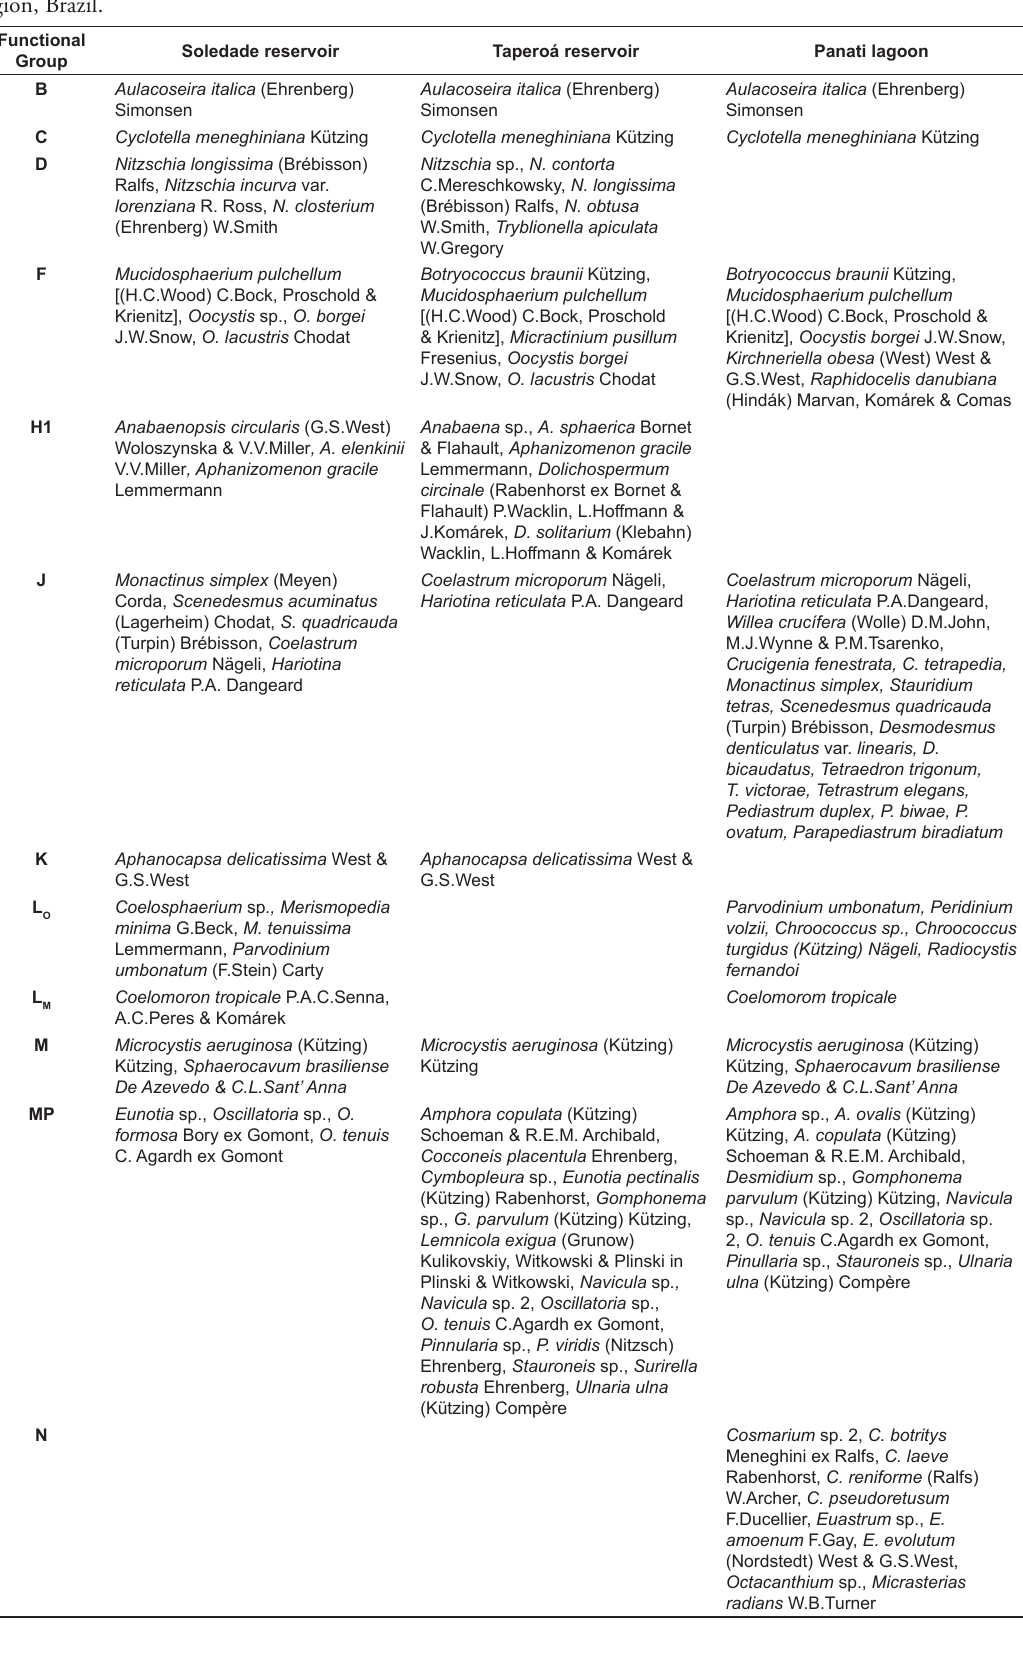
Table 2. Phytoplankton functional groups and respective species in three shallow aquatic ecosystems of semiarid region,